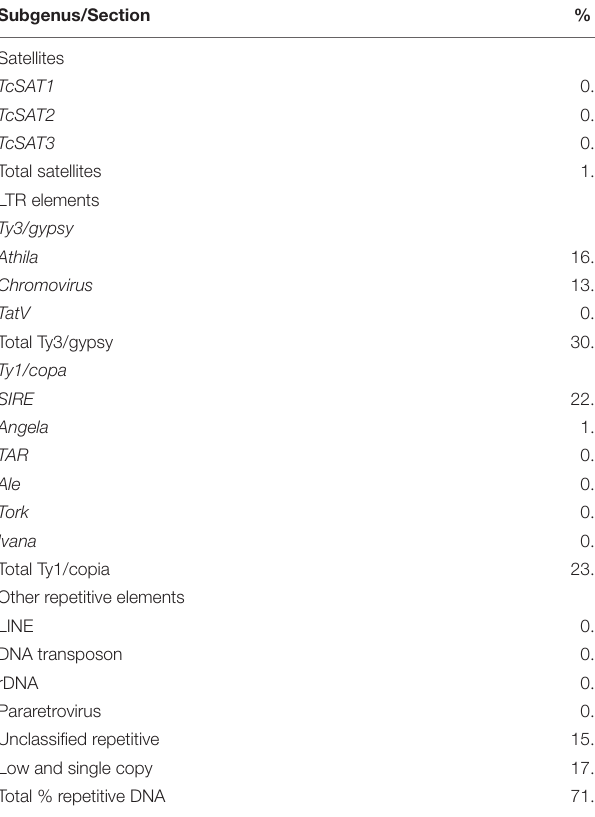
TABLE 3 | Major types of repetitive DNA in T. cinerariifolium .